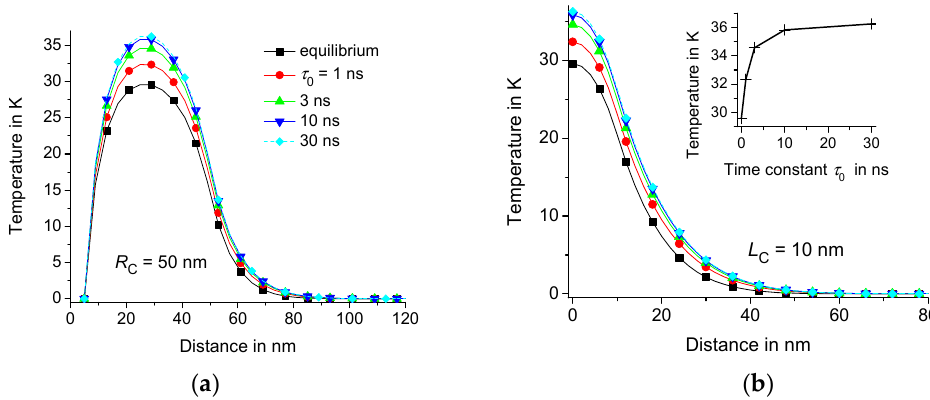
Figure 3. Temperature distribution T ( t , r ,0 ) vs. r ( a ) and T ( t , R C /2, z ) vs. z ( b ) at t = 1 ns, τ p = 2 ns, R C = 50 nm, L C = 10 nm, R 1 = 5 nm, R 2 = 150 nm, and L z = 100 nm. The equilibrium solution is represented by lines marked by squares and the nonequilibrium solutions at τ 0 = 1 ns, 3 ns, 10 ns, and 30 ns are represented by circles, upwards-facing triangles, downwards-facing triangles, and diamonds, respectively. T ( t , R C /2,0 ) vs. τ 0 at t = 1 ns is shown in the insert of Figure 3b.